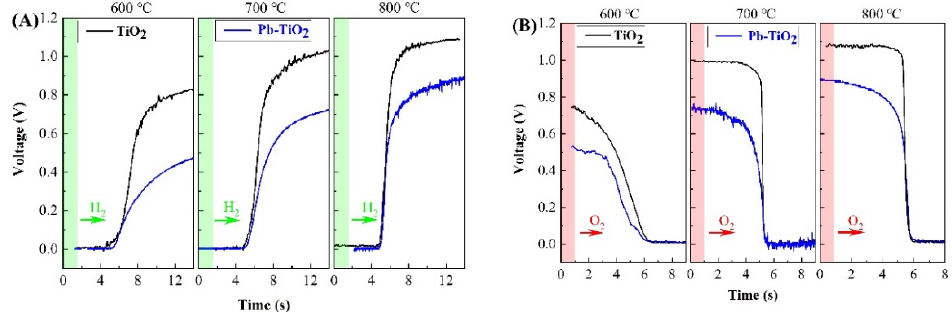
After oxygen is adsorbed by TiO 2 in the air, electrons can be abstracted from the material to form an O n − ad acceptor surface state due to the relatively high electron affinity of oxygen [35,36]. As a result, electrons from inside the grains diffuse to the grain boundary interface, causing the accumulation of negative charges on the interface, as shown in Figure 6. This forms a built-in electric field near the interface which hinders the further diffusion of carriers until the accumulation of negative charges on the interface reaches a stable state [9,34]. Reflected in the response characteristics, the resistance increases and the voltage decreases. On the contrary, the electrons released by the reducing gas (H 2 ) can lower the charge accumulation on the grain boundary and decrease the additional electrostatic potential energy of electrons near the interface after it adsorbs the reducing gas, which reduces the grain boundary barrier. This is reflected in the response characteristics; both the electric conductance and voltage increase. Obviously, when the Pb contaminants adhere to the surface of TiO 2 , the O n − ad content is greatly reduced, resulting in lowering of its grain boundary barrier and thus its sensitivity [41,42]. Peng et al. studied the influence mechanism of Pb on a CeO 2 -WO 3 /TiO 2 -SiO 2 catalyst. They also found that the introduction of Pb greatly reduced the number of surface acids and redox sites, thereby inhibiting the catalytic performance [43].